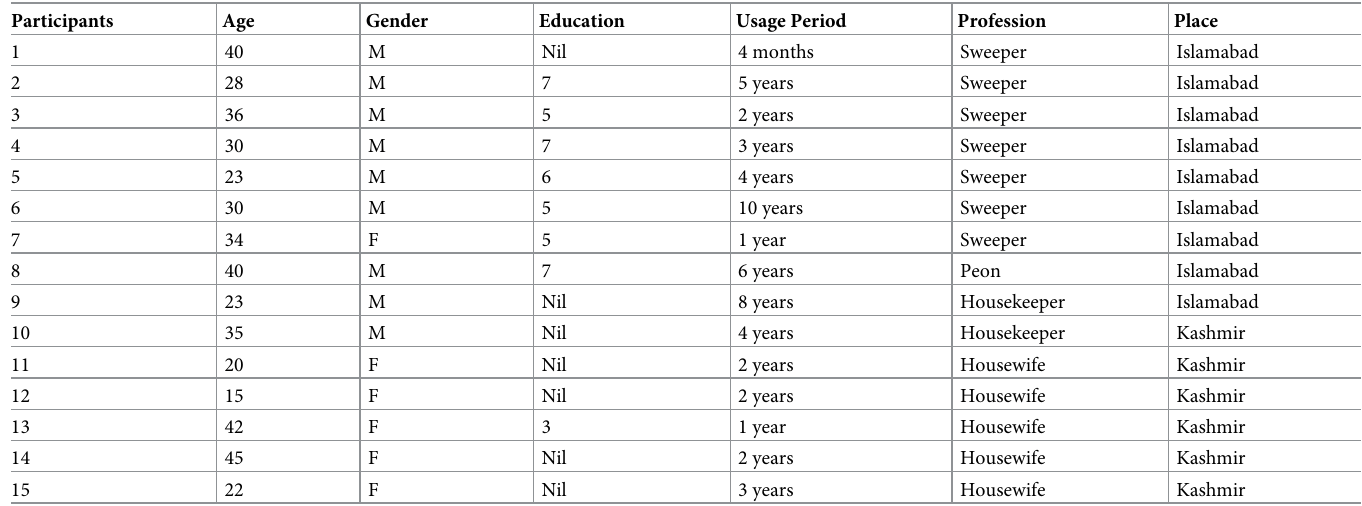
Table 1. Demographics of semi-structured qualitative study participants.